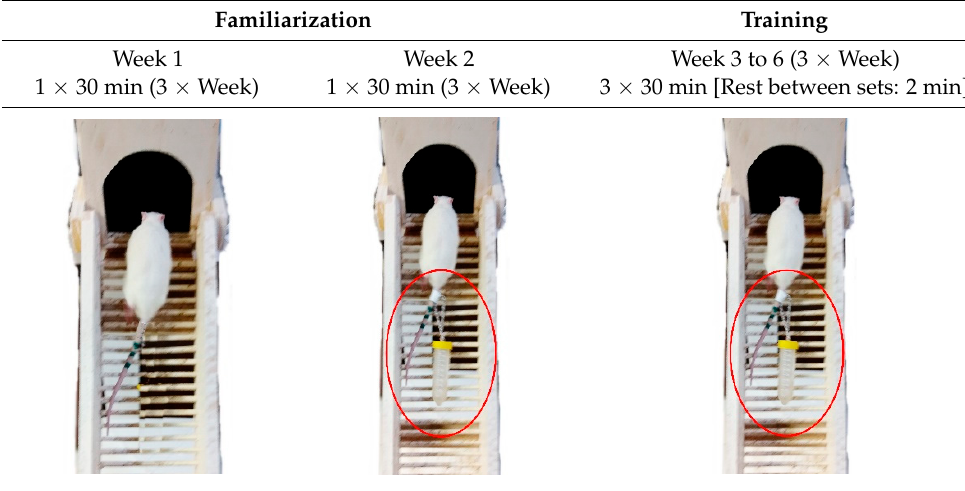
Table 1. Experimental drawing. Weekly training schedule.